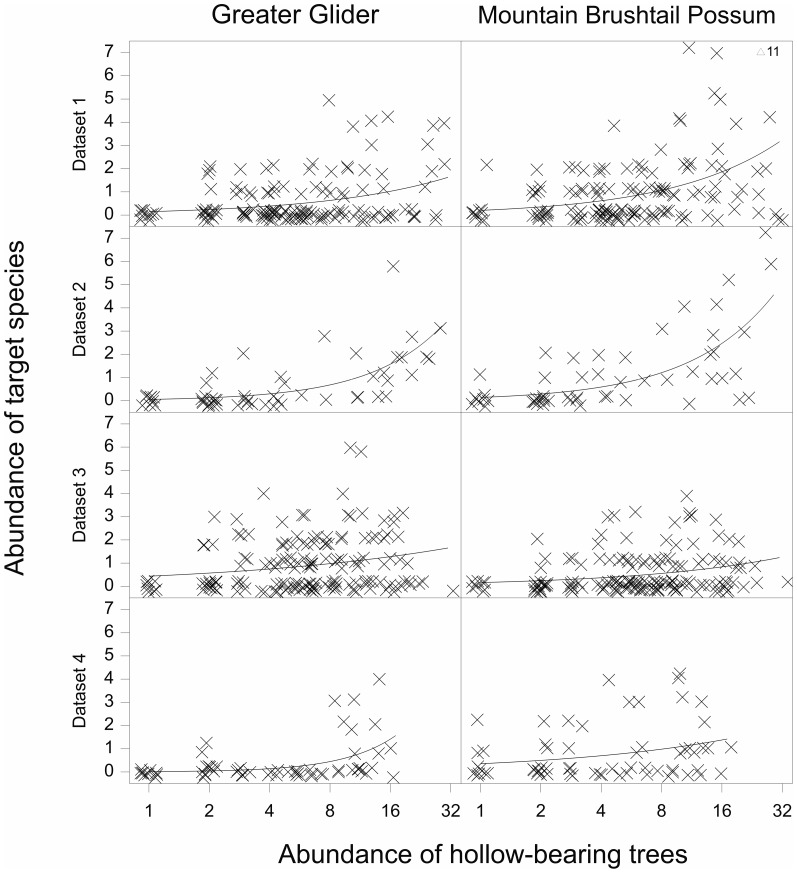
Observed and expected abundance of Greater Glider and Mountain Brushtail Possum.Observed and expected abundance, from the model with transformed counts of hollow-bearing trees as the explanatory variable, for all four datasets. Only one observation was greater than 7 animals, and this is indicated as an abundance of 11 Mountain Brushtail Possums in Dataset 1.